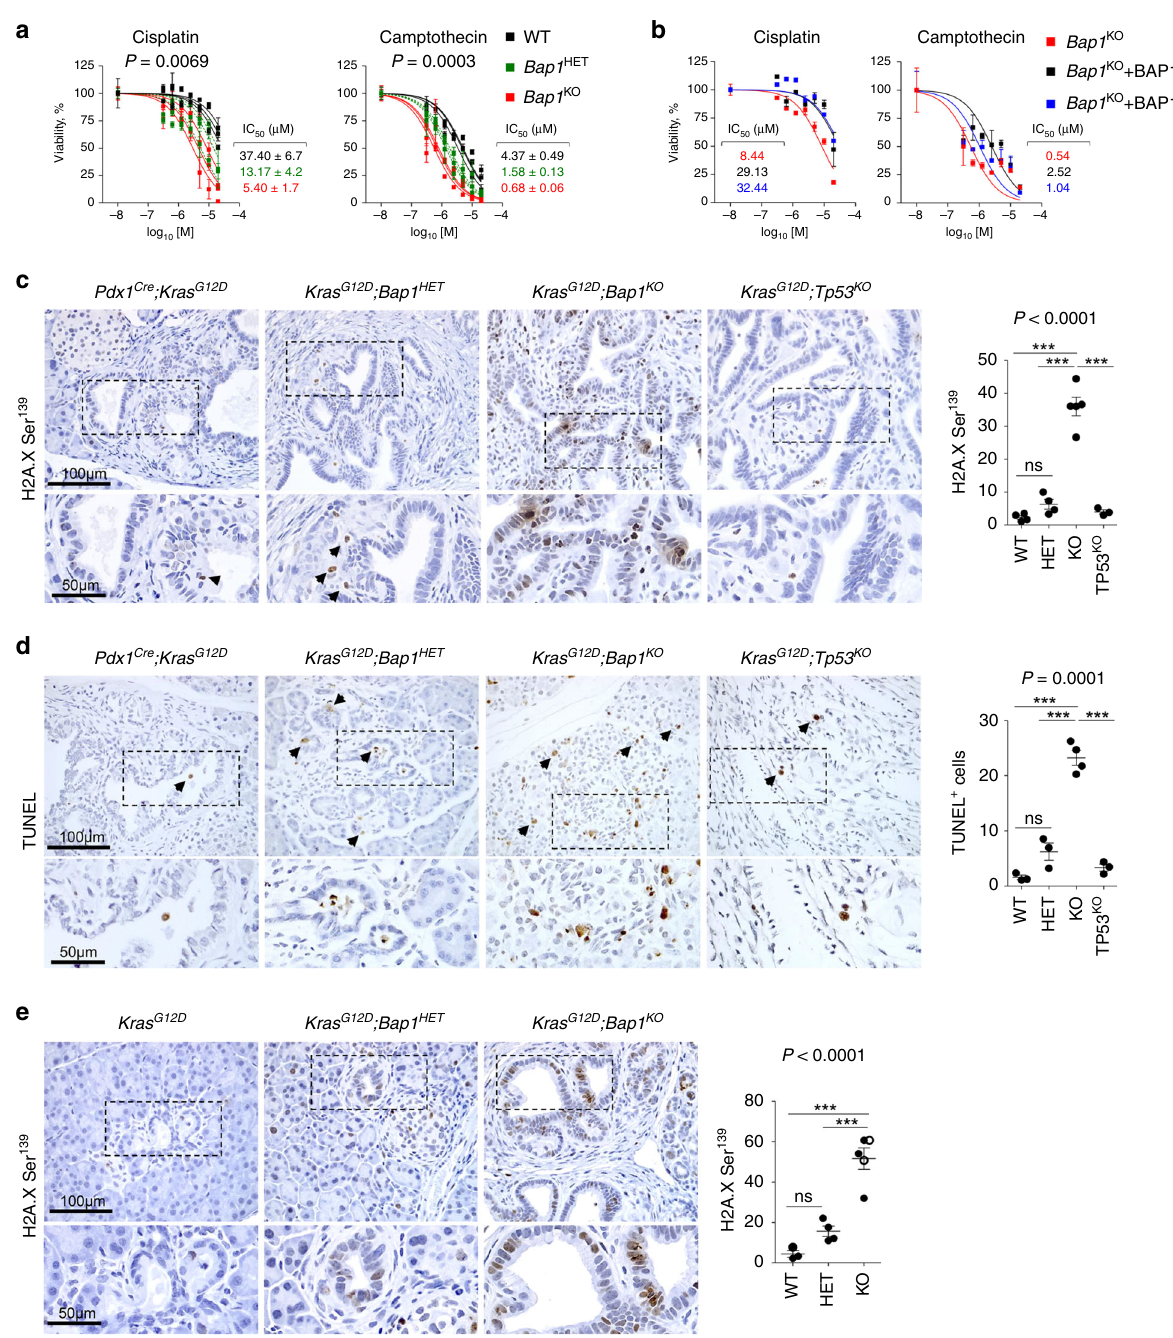
Fig. 7 BAP1 de fi ciency confers radio- and chemo-sensitivity. a Estimation of IC 50 values for cisplatin (left) and camptothecin (right) for wild-type ( n = 3), heterozygous ( n = 3), and Bap1 -knockout ( n = 3) pancreatic cell lines independently established from the Pdx1 Cre ;Kras G12D cohort and assessed in triplicates. The average IC 50 values (mean ± SEM) are shown. Statistical signi fi cance was determined by one-way ANOVA with p -values shown on the top of each plot. b Estimation of IC 50 values for cisplatin (left) and camptothecin (right) for a Bap1 -knockout pancreas cell line reconstituted with wild-type and BAP1 C91A mutant. The graphs show cell viability assessed in triplicates (mean ± SEM) for the indicated concentrations of compounds. c , d 10 – 15-week- old mice of the indicated genotypes were exposed to 10 Gy of IR. Three days later, mice were killed and pancreata were stained for ( c ) H2AXSer139 (WT n = 4, HET n = 4, KO n = 5, and TP53 KO n = 3 mice) and ( d ) TUNEL (WT n = 3, HET n = 3, KO n = 4, and TP53 KO n = 3 mice). e 6 – 10-week-old mice of the indicated genotype (WT n = 3, HET n = 4, and KO n = 5 mice) were treated weekly for 4 weeks with 5 mg/kg cisplatin. Mice were killed and pancreata were stained for H2AXSer139. In c – e , the scatter dot plots show the number of positive cells (mean ± SEM) per 0.1 mm 2 of tissue per mouse. Each dot represents a mouse. Black arrows point to positively stained cells. Filled and open circles indicate mice from the Pdx1 Cre and Ptf1 α Cre cohorts, respectively. Statistical signi fi cance was determined by one-way ANOVA with p -values shown on the top of each plot, followed by Tukey ’ s multiple comparison post- hoc test between groups. ns, nonsigni fi cant; *** p < 0.001. Source data are provided as a Source Data fi